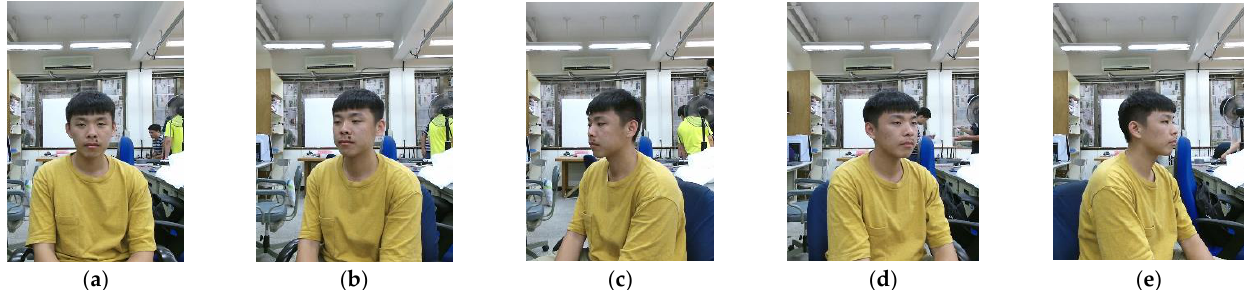
Figure 6. 2D RGB images of different angle of rotation relative to camera: ( a ) front view (A); ( b ) turn left 30 degrees (B); ( c ) turn left 60 degrees (C); ( d ) turn right 30 degrees (D); ( e ) turn right 60 degrees (E).